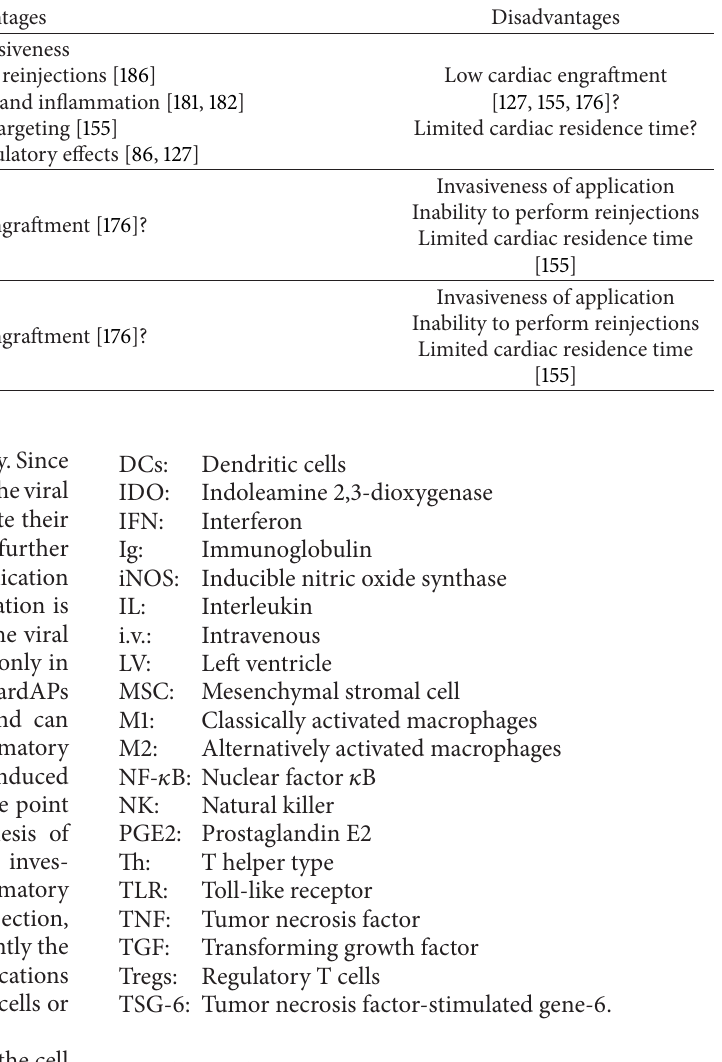
Table1:Advantagesanddisadvantagesofdifferentcelladministrationroutesforthetreatmentofinflammatorycardiomyopathy.Aslongasno studies are performed directly comparing the effectiveness of intravenous versus endocardial and intracoronary application in inflammatory cardiomyopathy, one cannot conclude that extracardiac targeting of MSCs is superior to high cardiac